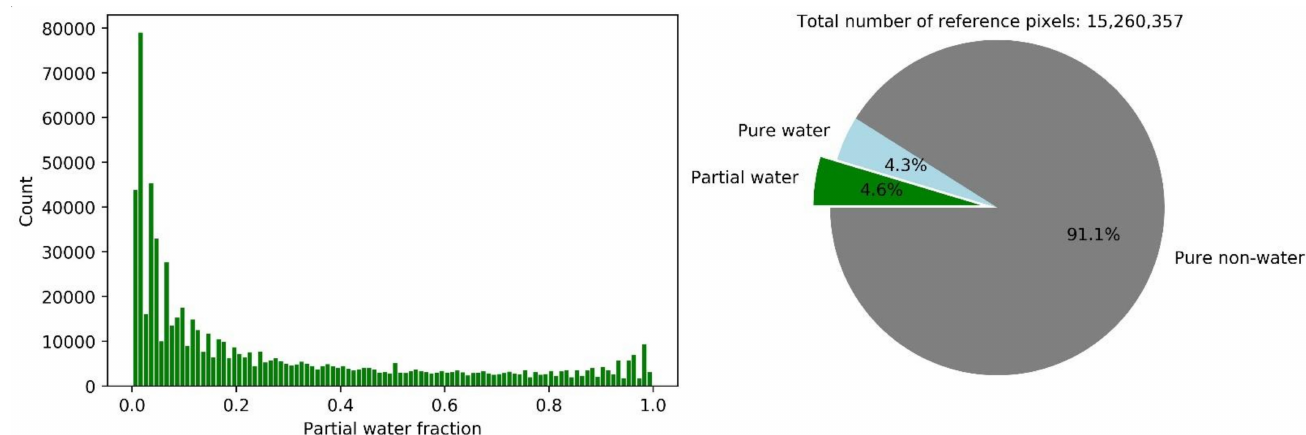
Figure 8. Distribution of reference pixels according to coverage categories. The histogram shows only partial water fraction pixels (0% < x <